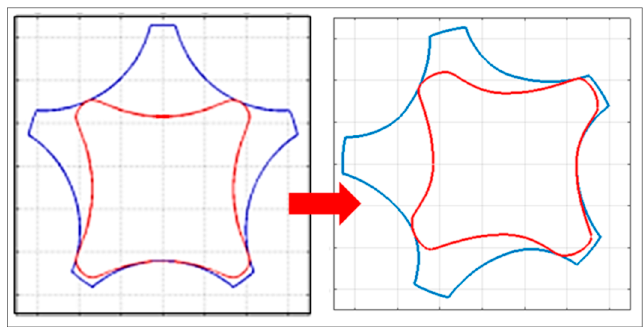
Figure 18. Second-order optimization: mass.